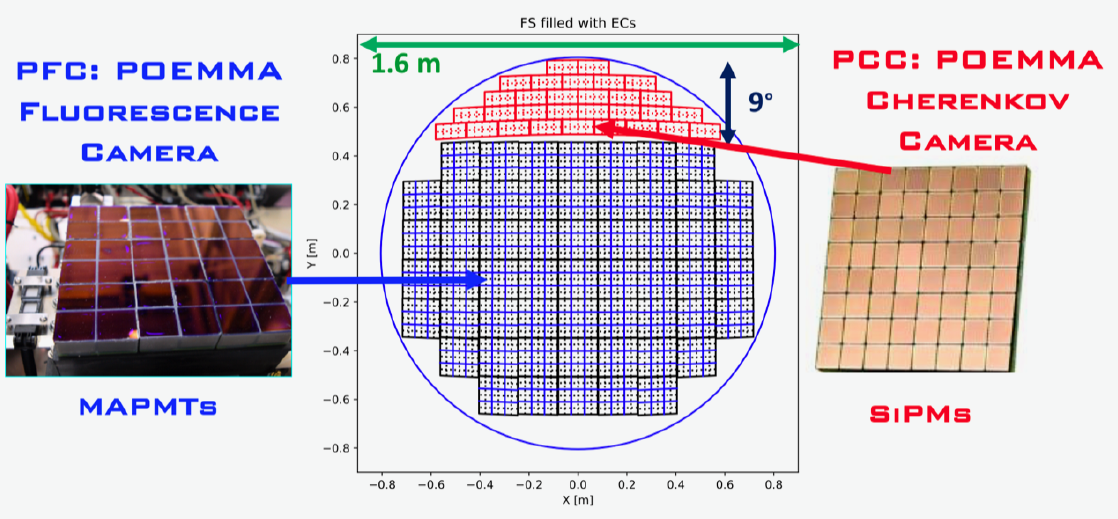
Figure 4. The layout of a POEMMA Schmidt telescope focal plane with PDM and FSU modules. The 9 ◦ angular span of the PCC segment is